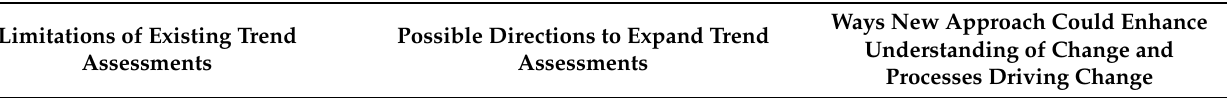
Table 5. Limitations of existing snowpack and climate trend assessments and opportunities to enhance